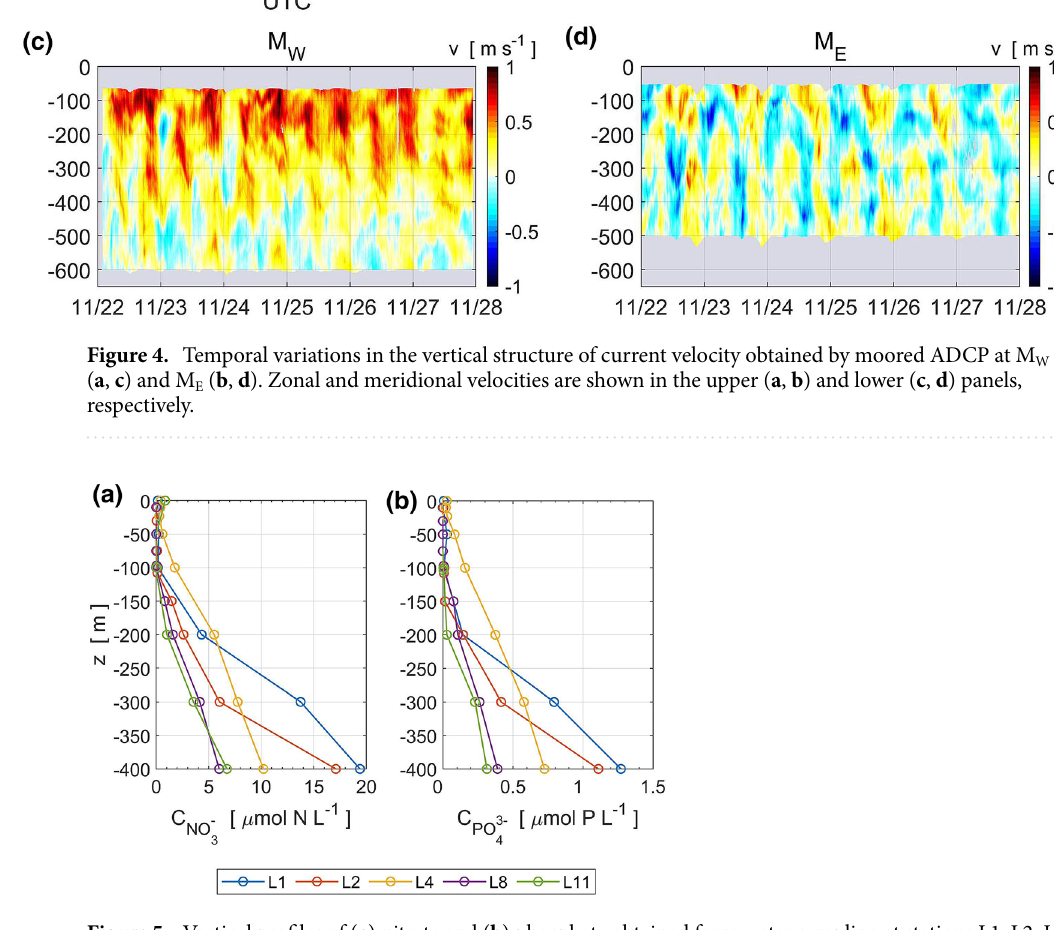
and phosphate are estimated using the vertical gradient of nitrate and phosphate along with the vertical eddy diffusivity [see Eq. (1) in “Methods” section], which are shown in Fig. 6c and d, respectively. As expected, a much larger vertical flux of nitrate is seen around the sub-ridge than on the open ocean side. The maximum value of the nitrate (phosphate) flux was found at L4, reaching 4.7 mmol N m −2 d −1 (0.33 mmol P m −2 d −1 ) at around 100-m depth (Fig. 7). Because the typical thickness of the euphotic zone is 100 m in this region 34 , we hypothesize that the enhanced vertical fluxes of the nitrate and phosphate may contribute to the primary production in the upper layer. Surface chlorophyll a bloom.